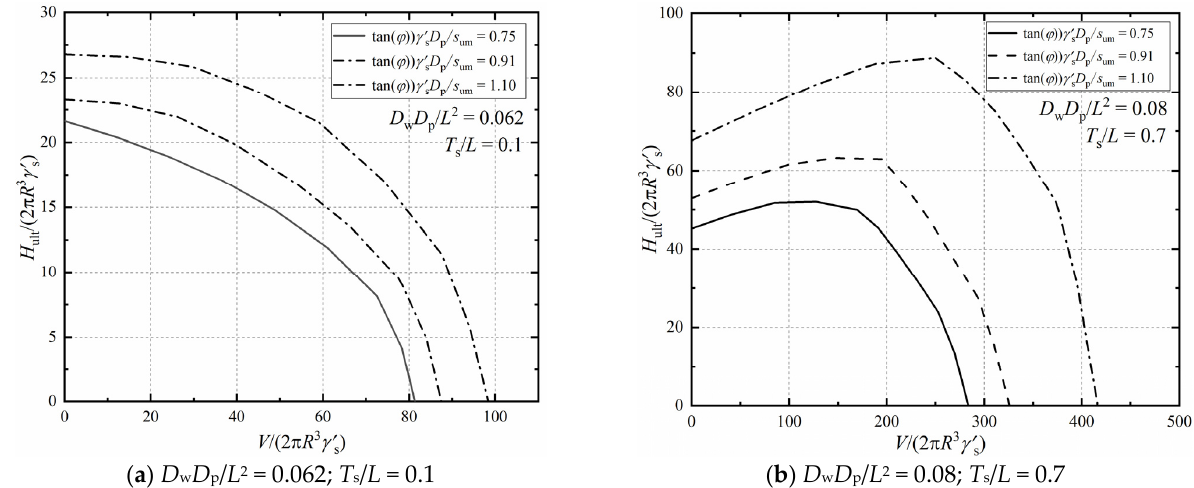
Figure 9. Effects of soil properties (tan( ϕ ) γ ′ s D p / s um ).